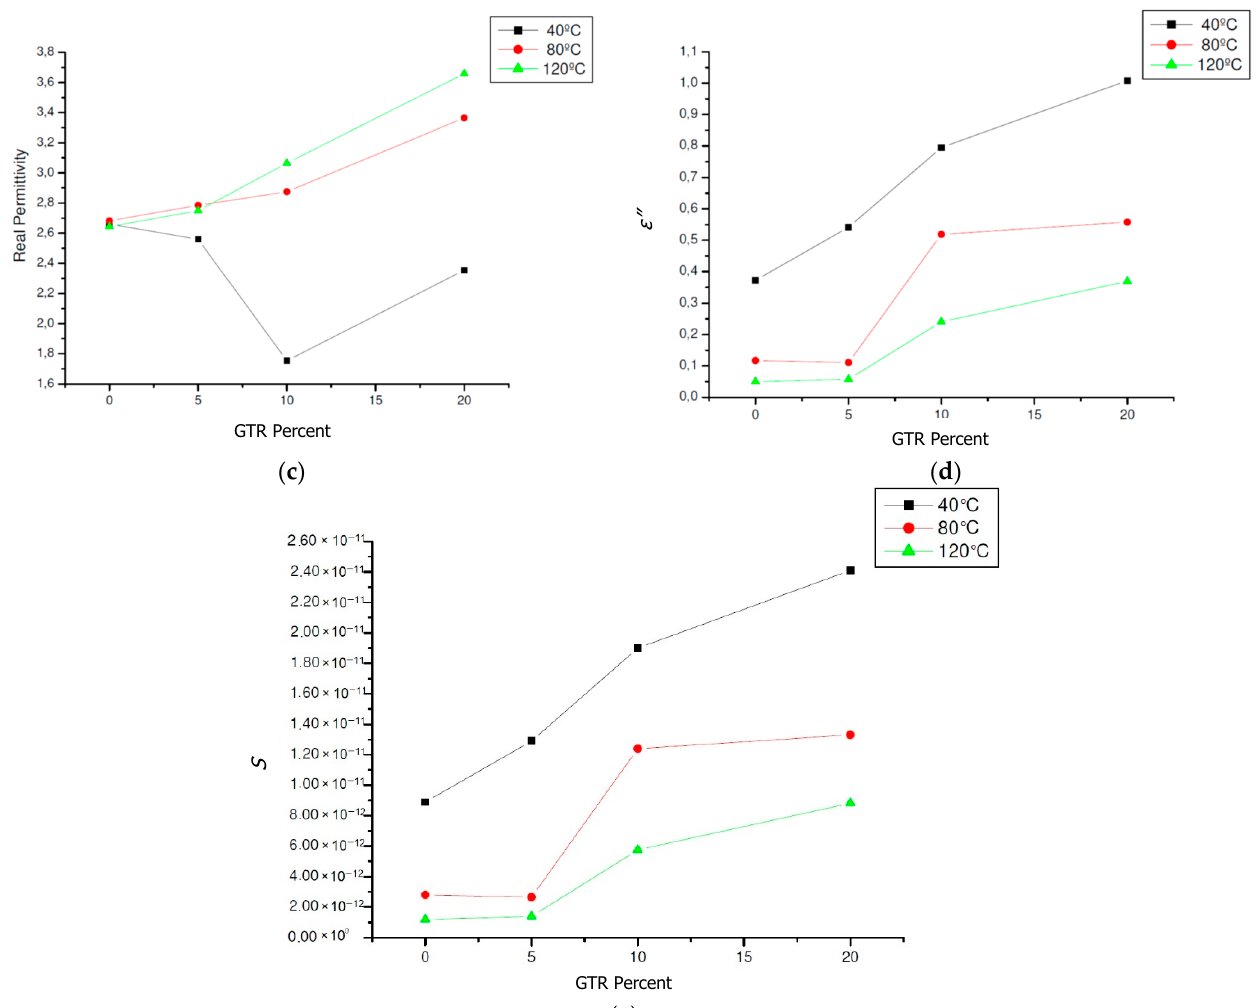
Figure 10. EPDM and GTR samples composites dielectric behavior, at frequency: 50 Hz, and different temperatures: 40 °C, 80 °C and 120 °C ( a ) real modulus; ( b ) imaginary modulus; ( c ) real permittivity; ( d ) imaginary permittivity; ( e ) S-Conductivity (S/cm) in EPDM composites for neat EPDM (0% GTR) and EPDM and GTR (5–10–20% GTR).